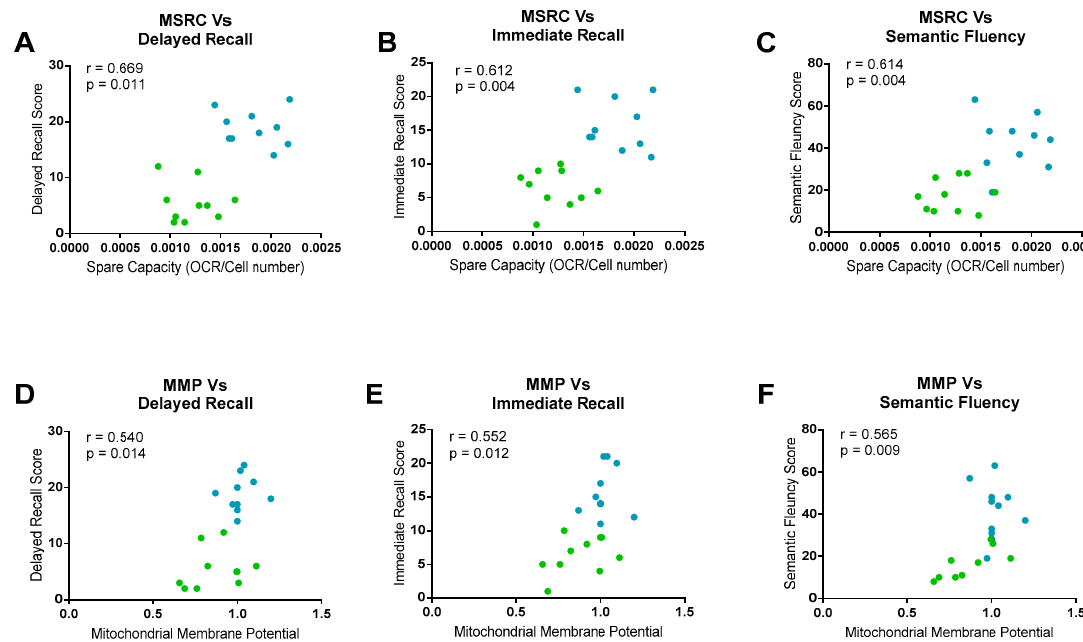
Figure 3. Neuropsychological Fibroblast Metabolism Correlations. Significant correlations were seen between mitochondrial spare respiratory capacity (MSRC) and delayed recall ( A ), Immediate recall ( B ) and semantic fluency ( C ). Mitochondrial membrane potential (MMP) correlated significantly with semantic fluency ( F ), and with delayed recall ( D ) and immediate recall ( E ) but to a lesser extent. For all panels controls are represented in blue and sAD are represented in green. Correlation coe ffi cients and p -values for each correlation are